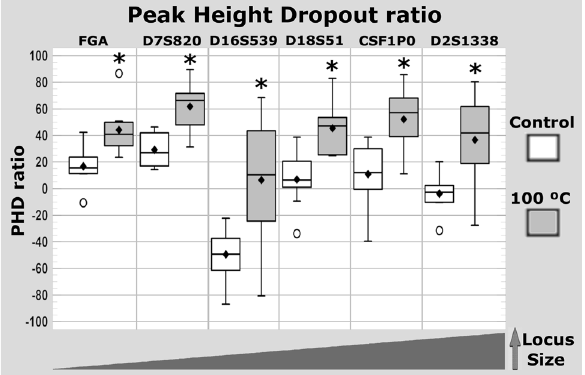
Figure 2. Box and whisker plot of locus peak height dropout (PHD) ratio in control and 100 °C groups. Dropout ratio was calculated as the percentage peak height dropout of the smallest locus (amelogenin) relative to the largest loci (FGA, D7S820, D16S539, D18S51, CSF1P0 and D2S1338). *Significant differences (p < 0.01) between control group teeth and teeth incinerated at 100 °C for 60